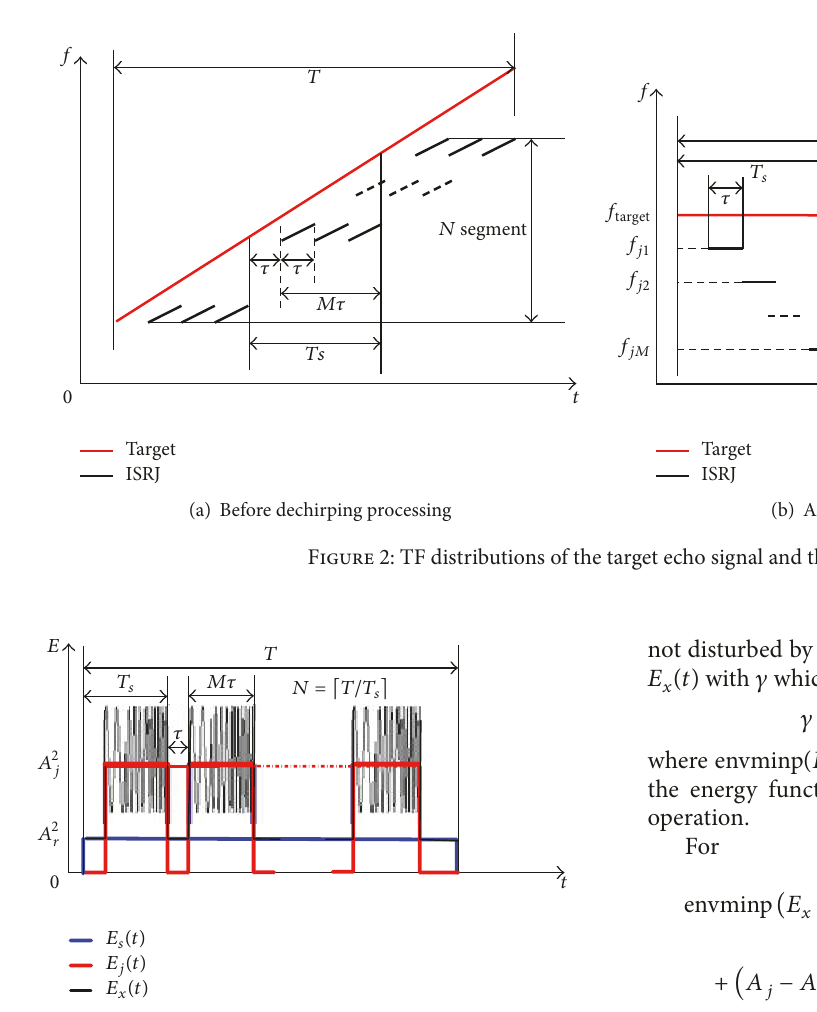
Figure 1: The principle of the interrupted-sampling and periodic repeater jamming.